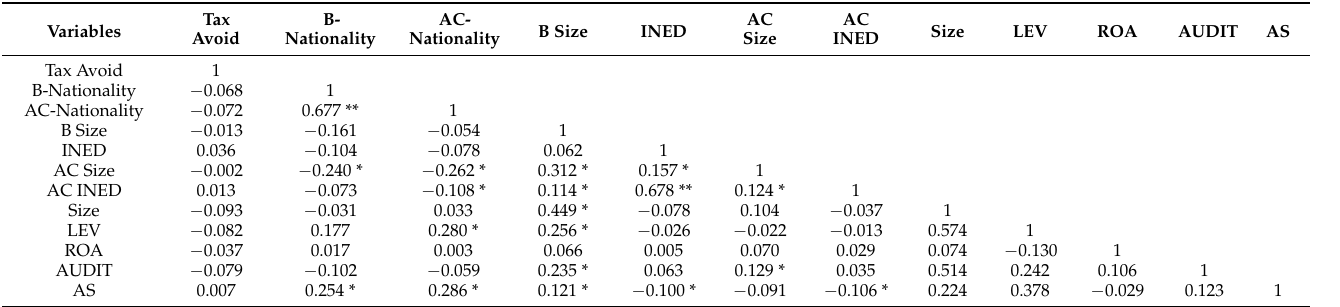
Table 3. Correlation analysis.